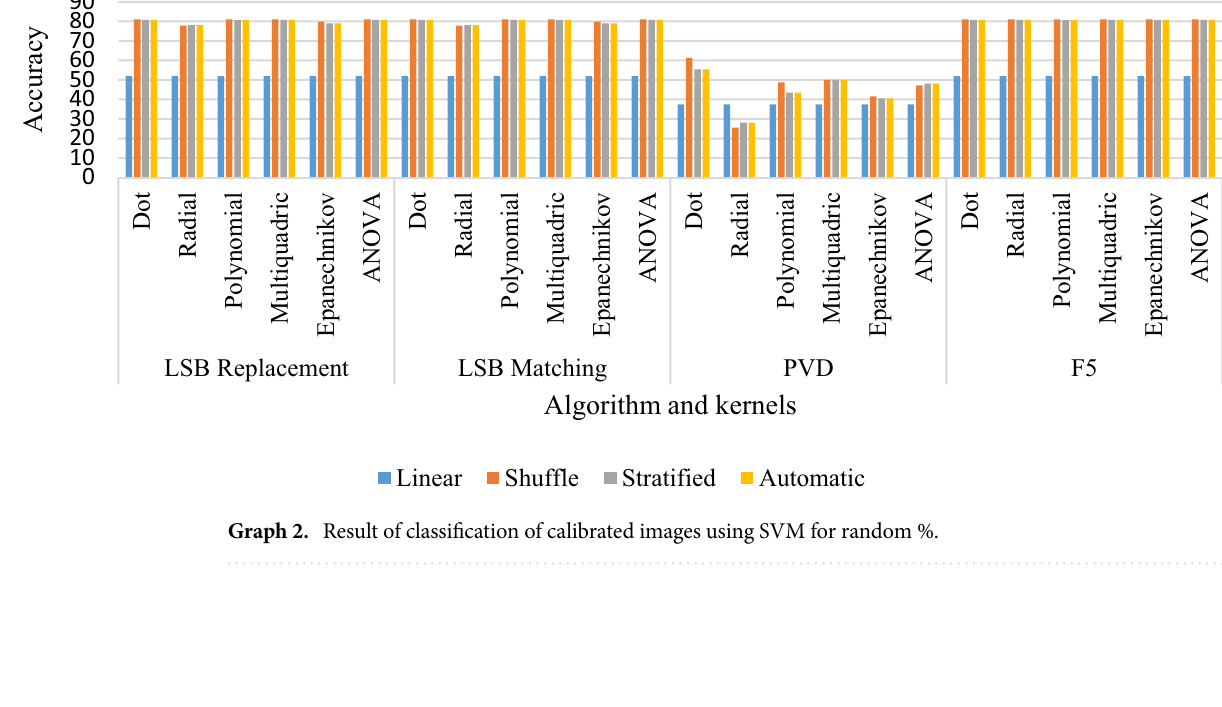
Linear Shuffle Stratified